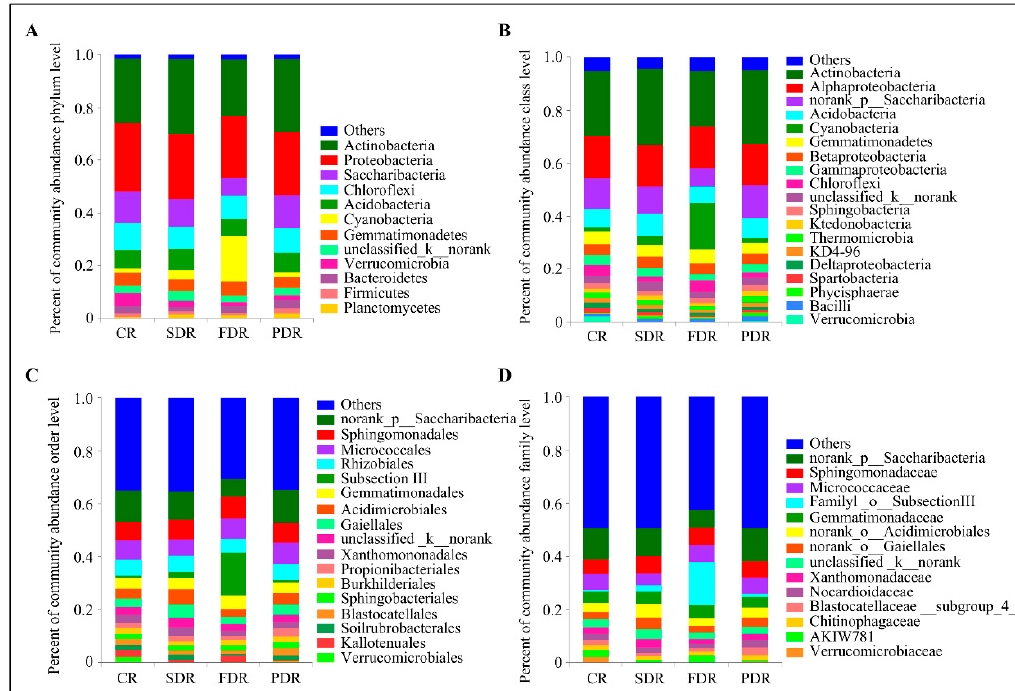
Figure 2. Microbial community structure in peanut rhizosphere at the phylum, class, order and family level. ( A ) Percent of microbial community abundance at the phylum level in four soil groups in peanut rhizosphere. The relative abundance is calculated by averaging the abundances of duplicate samples in each soil group in peanut rhizosphere. ( B ) Percent of microbial community abundance at the class level in four soil groups in peanut rhizosphere. The relative abundance is calculated by averaging the abundances of duplicate samples. ( C ) Percent of microbial community abundance at the order level in four soil groups in peanut rhizosphere. The relative abundance is calculated by averaging the abundances of duplicate samples. ( D ) Percent of microbial community abundance at the family level in four soil groups in peanut rhizosphere. The relative abundance is calculated by averaging the abundances of duplicate samples. The names of “norank” and “unidentified” are all unidentified species obtained directly from database via sequence alignment.